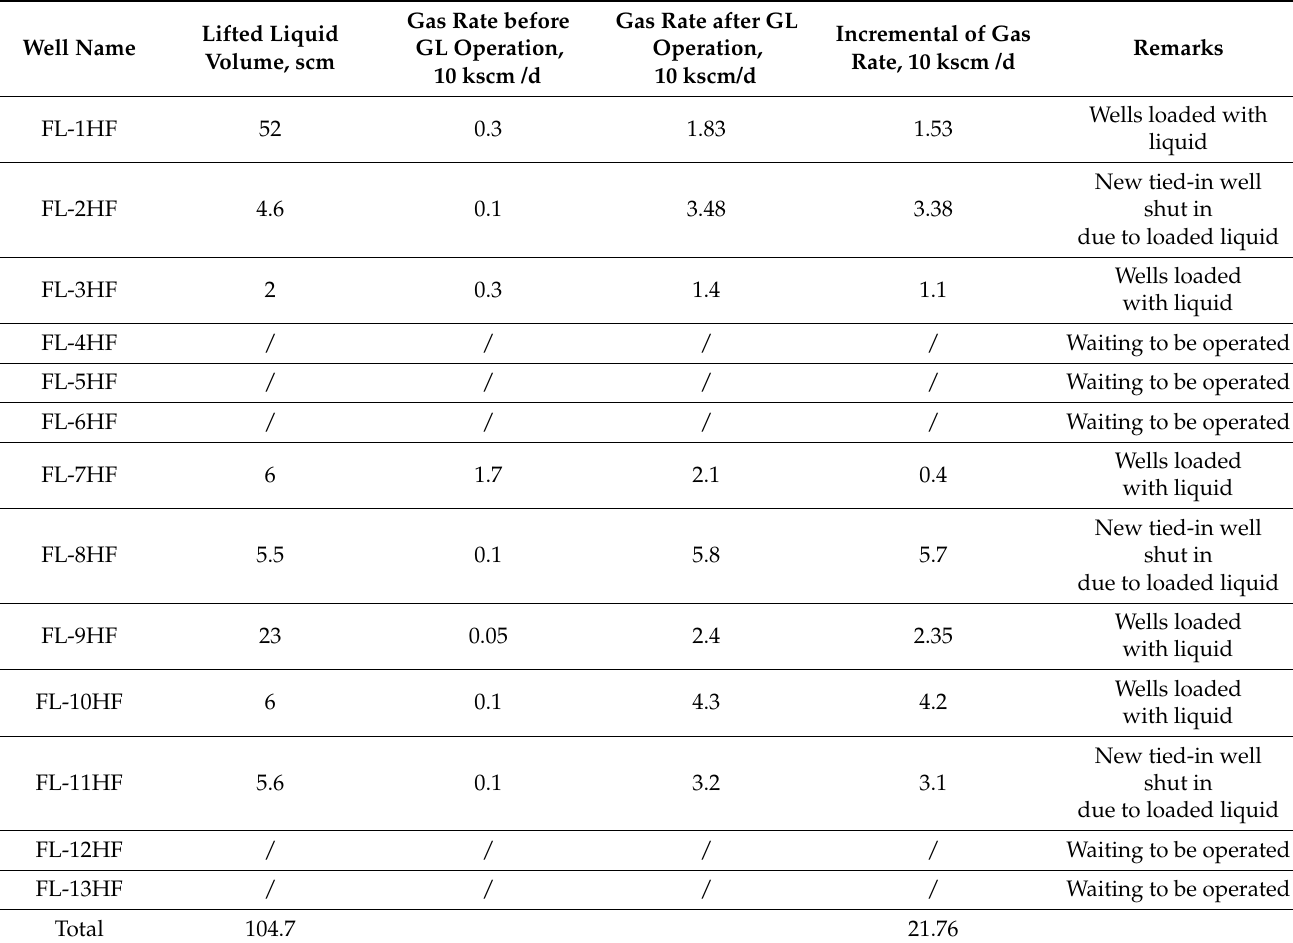
Table 5. Gas lift result with the new gas lift